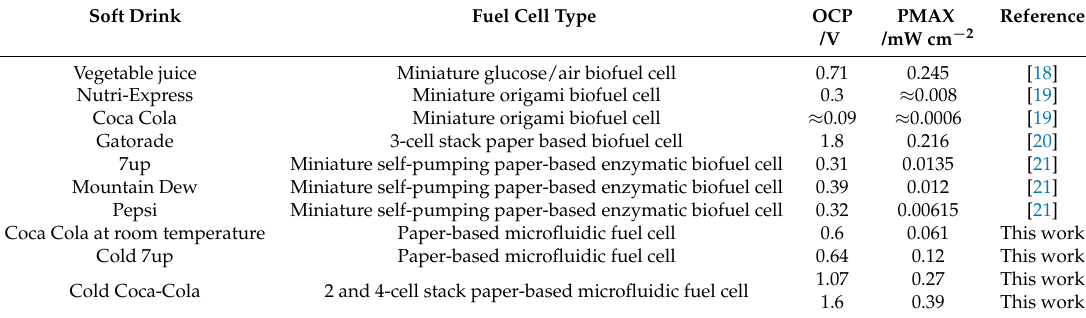
(cid:13) as fuel and air as